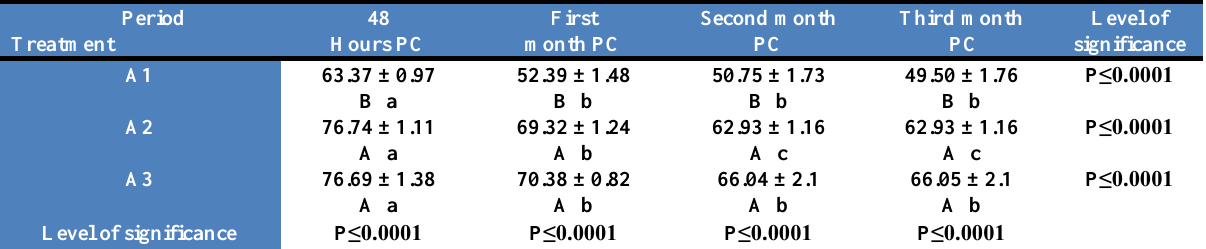
Table, 1: The Effect of adding manganese chloride to Tris extender on the freeze ability percentage (FA%) at different post-cryopreservation (PC) periods in Holstein bulls semen (M ±S.E).